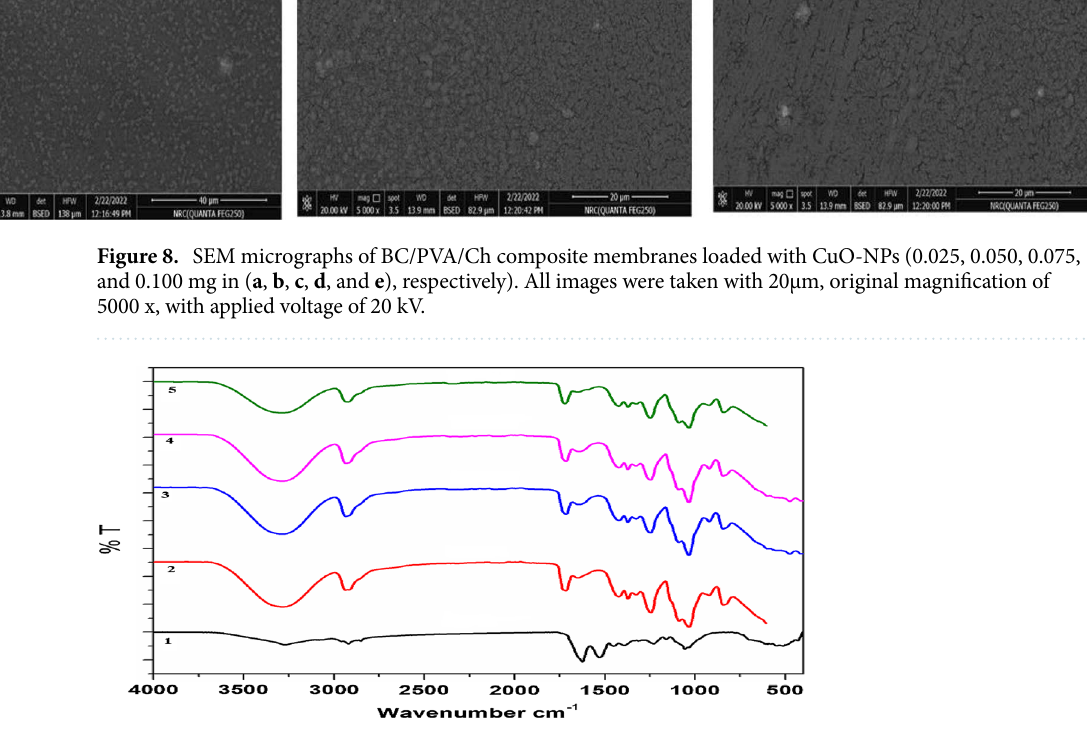
Figure 9. FT-IR analysis of BC/PVA/Ch (1), BC/PVA/Ch/CuO-NPs1 (2), BC/PVA/Ch/CuO-NPs2 (3), BC/ PVA/Ch/CuO-NPs3 (4), and BC/PVA/Ch/CuO-NPs4 (5) composite